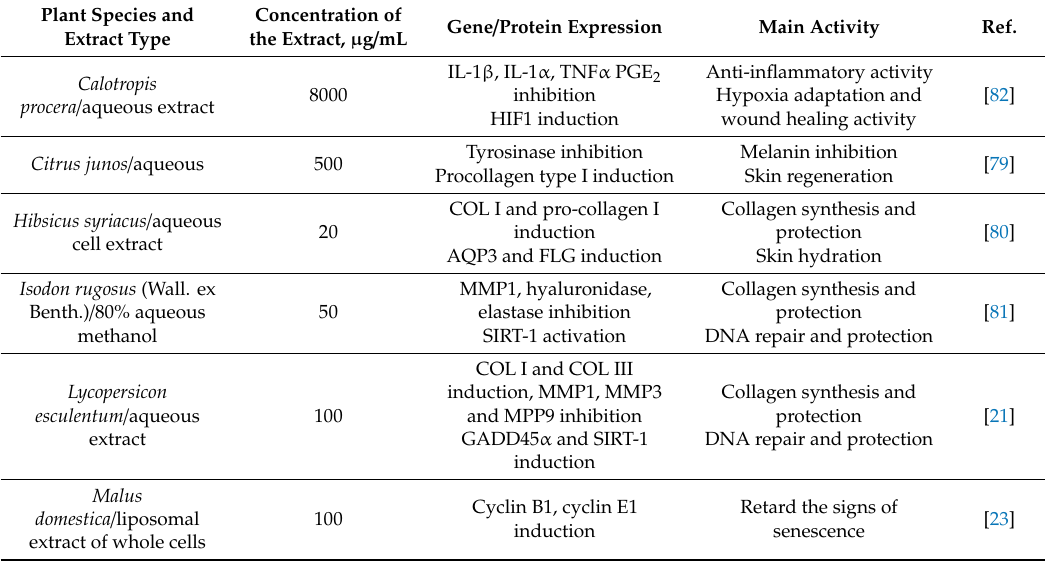
Table 2. Activities of plant cell culture extracts and their modulation activity on gene expression in skin cells in vitro